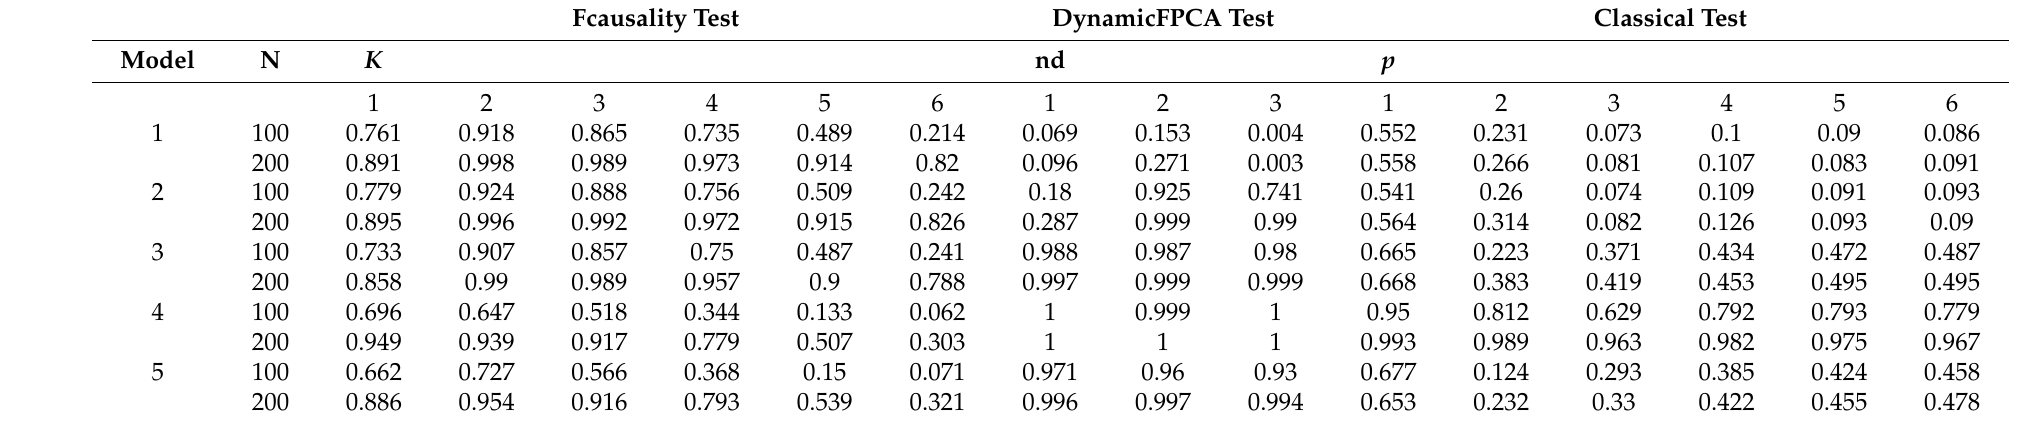
Table 3. Power on five different